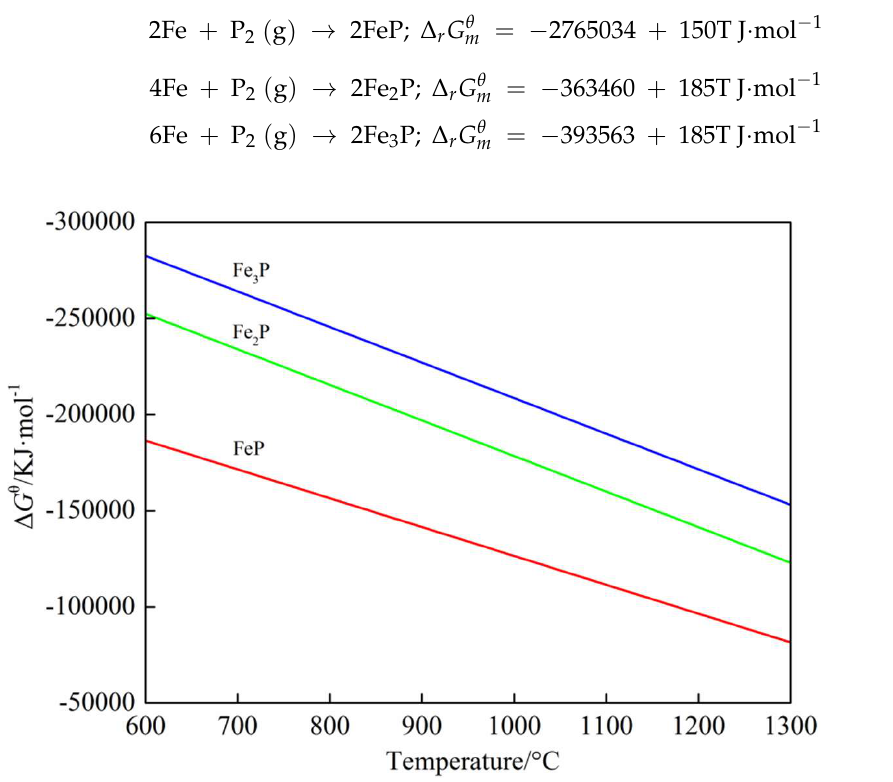
Figure 11. The correlation of ΔG θ with temperature for Equations (8)–(10).